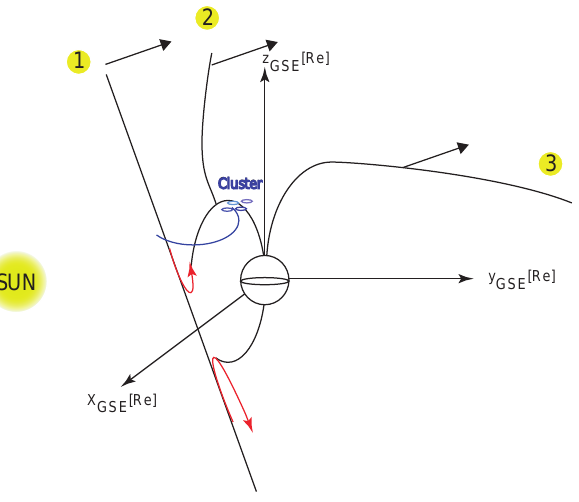
Fig. 5. Schematics of the time sequence of reconnected field lines at the dayside magnetopause. The Cluster path on 14 January 2001 is indicated by a blue